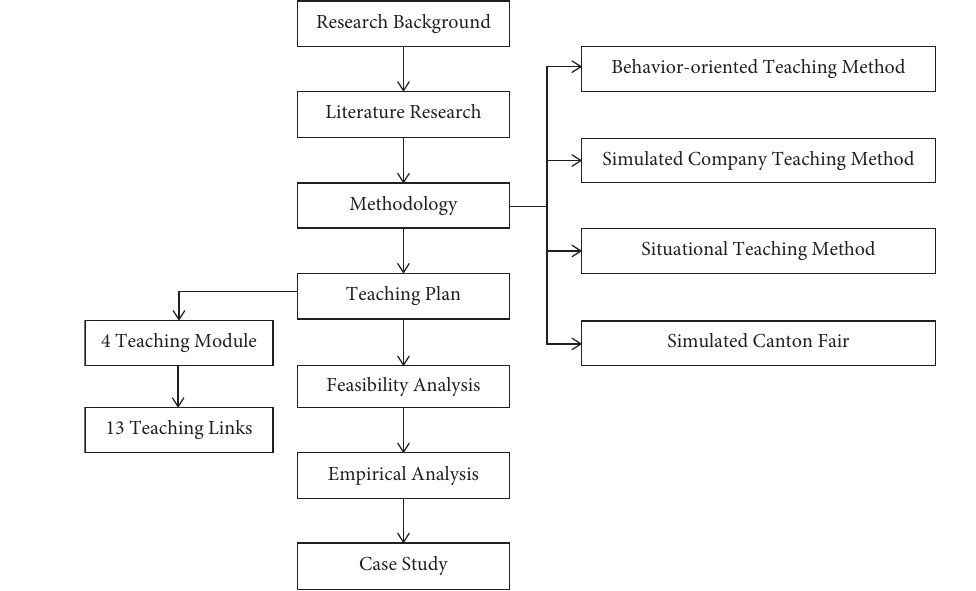
Figure 4: Technical route of the